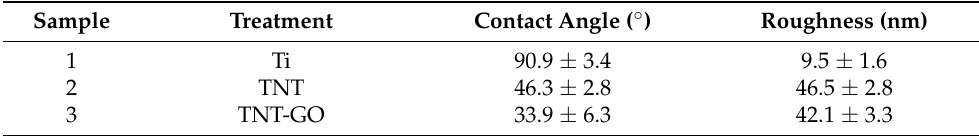
Figure 2. Surface analysis of the Ti, TNT, and TNT-GO samples. ( A ) Reconstructed topographical images of the samples determined from atomic force microscopy; ( B ) water contact angles; ( C ) unbound and bound protein concentrations; ( D ) nanoscratch results for TNT and TNT-GO. Red arrow and force fluctuations indicate fracture at a displacement of 530 µ m. (* p < 0.05). Table 1. Water contact angles and surface roughness of the samples.